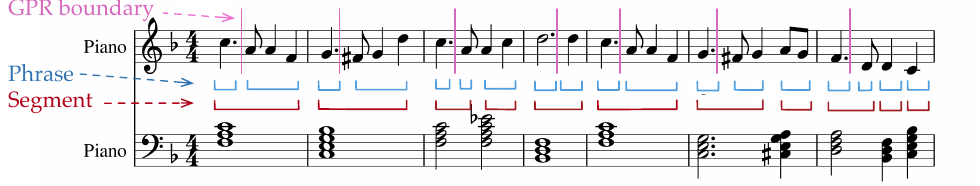
Figure 1. Phrases and segments in “Auld Lang Syne” . The segment’s start and end align with the change of chords. The phrases are subunits of the segments and are acquired by splitting the segments with the GPR boundary rules (Grouping Preference Rules [17] in the Generative Theory of Tonal Music (GTTM) [18]), which is introduced in Section